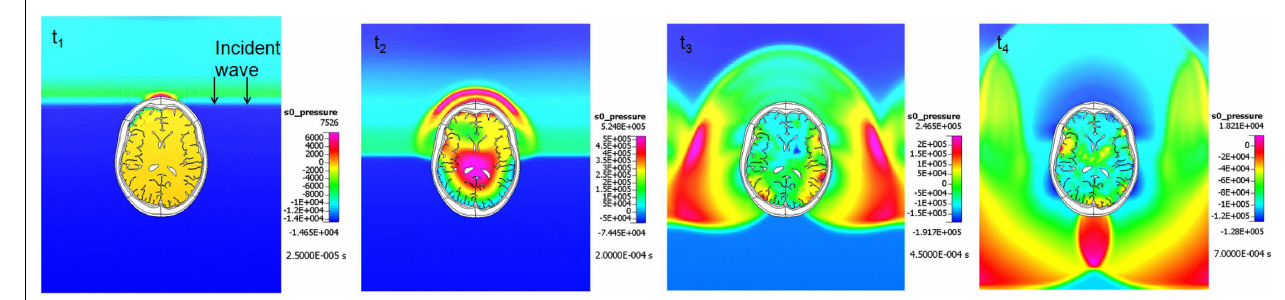
FIGURE 9 | Example coupled CFD-FEM simulation results of a blast wave diffraction around, and transmission through a human head. A sequence of four time instances.